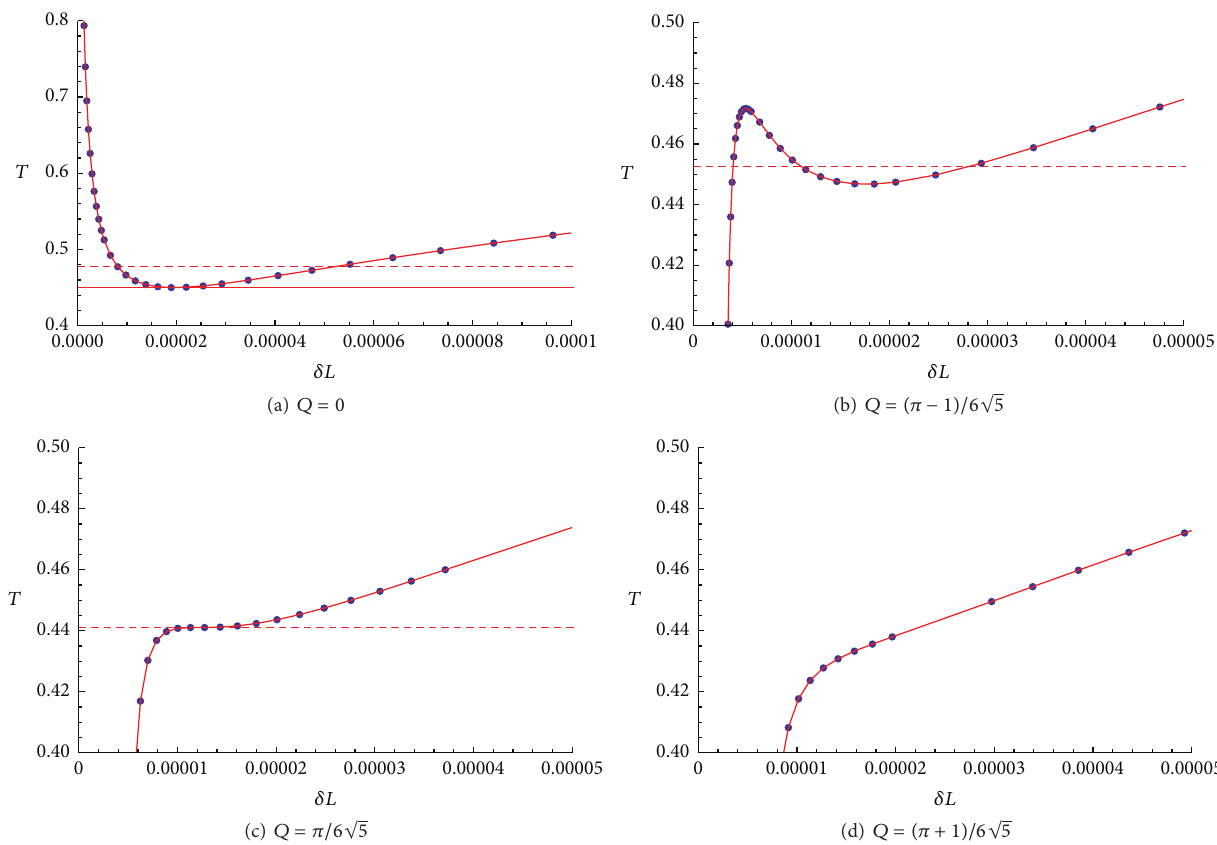
Figure 4: Relation between the geodesic length and temperature in the fixed charge ensemble for different charges at 𝜃 0 = 0.2 . The red solid line corresponds to the location of the minimum temperature 𝑇 0 ; the dashed lines in (a), (b), and (c) correspond individually to the locations of Hawking-Page phase transition 𝑇 1 , first-order phase transition 𝑇 ⋆ , and second-order phase transition 𝑇 𝑐 .